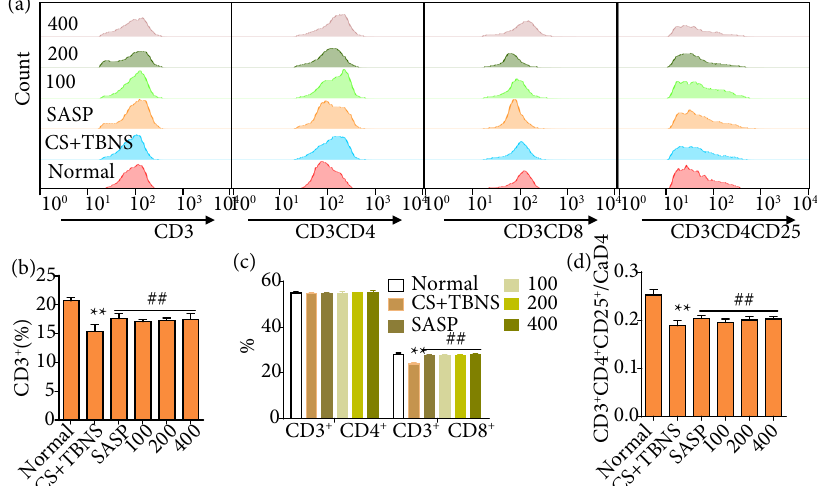
Figure 6 - Effects of Periplaneta americana L. on T cell subtypes in the spleen in rats after chronic stress with ulcerative colitis. CD3 + CD4 + T lymphocytes, CD3 + CD8 + T lymphocytes, CD3 + CD4 + CD25 + regulatory T lymphocytes percentage were measured by flow cytometry. (a) Histogram of flow cytometry in each group; (b) CD3 + T lymphocytes; (c) CD3 + CD4 + T lymphocytes and CD3 + CD8 + T lymphocytes in spleen; (d) the ratio of CD3 + CD4 + T lymphocytes to CD3 + CD8 + T lymphocytes; (e) the ratio of CD3 + CD4 + CD25 + regulatory T lymphocytes to CD3 + CD4 + T lymphocytes. Data were presented as mean ± standard deviation (n = 4 per